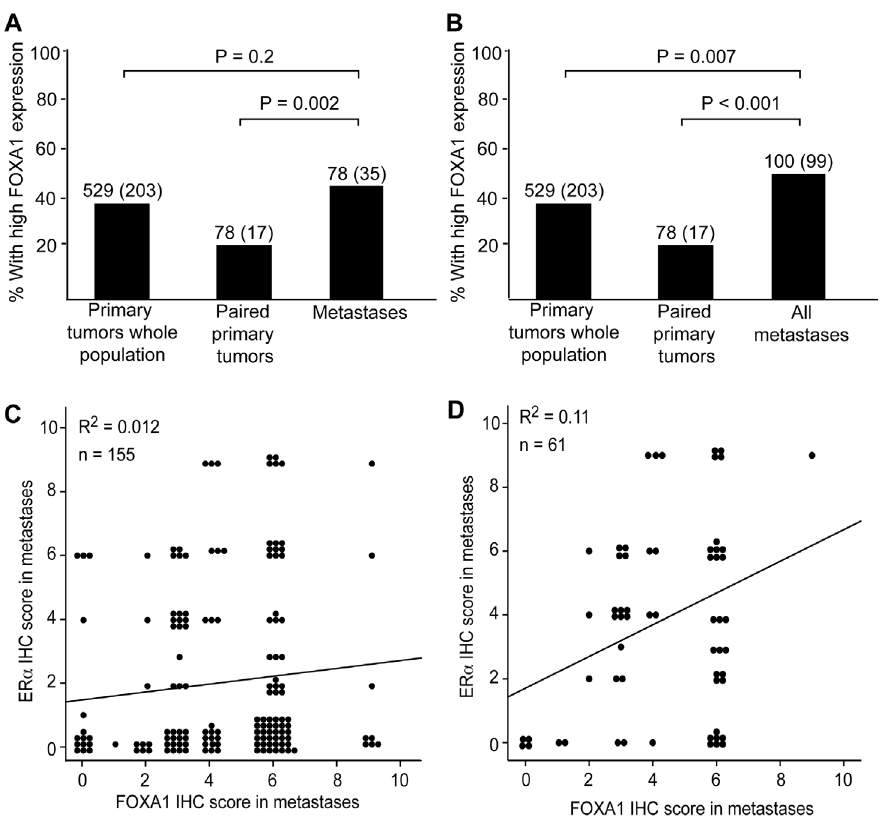
Figure 3. Increased expression of FOXA1 in metastases. (A) FOXA1 expression is retained from primary tumors to metastases, while the expression is significantly increased from paired primary tumors to their corresponding metastases. FOXA1 is defined as low if any of the metastatic lesions from the individual cases explored (n=78) demonstrated low expression. (B) Looking at all metastases (n=199) there is a significant increase in expression from primary to metastatic lesions. Numbers indicate number of cases investigated with number of cases with high expression in parenthesis. (C) There is no correlation between FOXA1 and ER a expression in metastases and the correlation between FOXA1 and ER a expression in metastases only from ER a positive primary tumors is low (D).